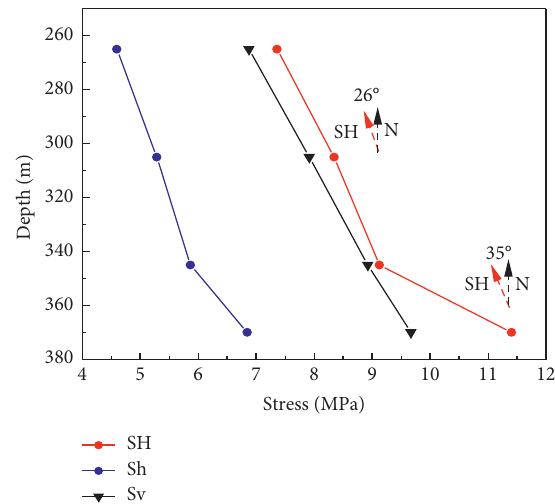
Figure 3: Diagram of in situ stress information (here SH: the maximum horizontal principal stress; Sh: the minimum horizontal principal stress; Sv: the vertical stress).